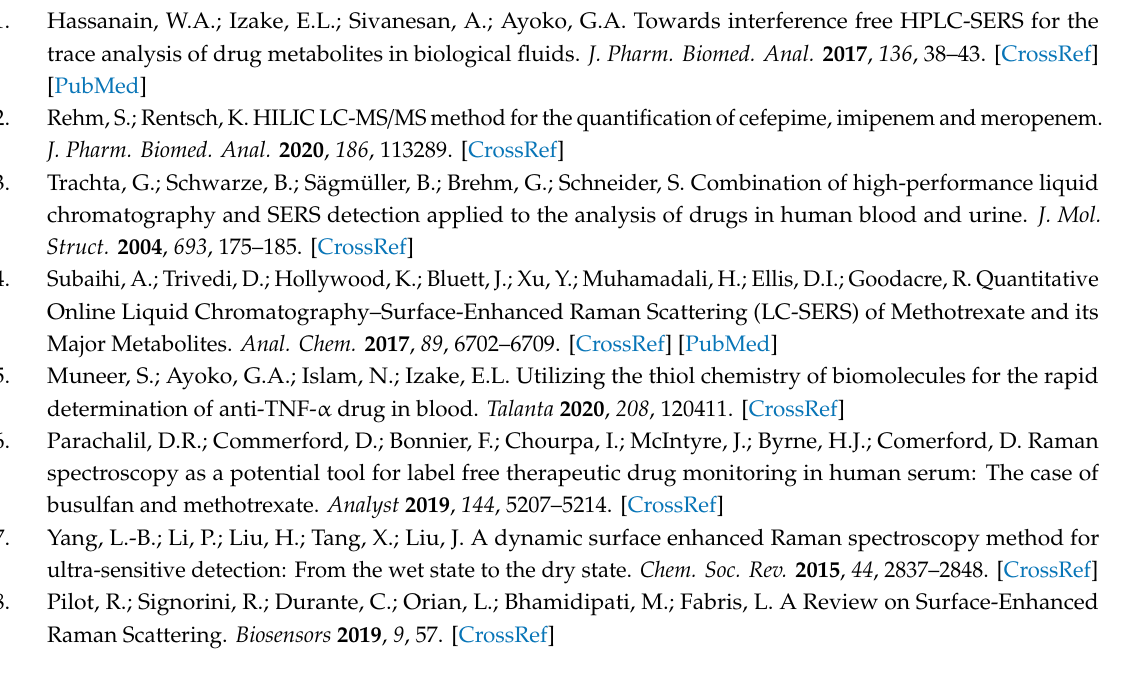
Figure S1. (a) SEM images of gold deposition on nickel foam at di ff erent acquisition times 600, 900, and 1200 s (resolution 1 µ m); (b) SERS spectrum of 2-QT (10 − 6 M) at di ff erent acquisition times 600, 900, and 1200 s; (c) 2-QT on bare nickel foam substrate (10 − 2 M); (d) 2-QT on plasmonic nickel foam substrate (10 − 12 M). Figure S2. Chemical structure of: (a) meropenem; (b) paracetamol. Figure S3. (a) Reproducibility of SERS measurements in human blood plasma (RSD = 2.86%); (b) reproducibility of signals on SERS measurements in aqueous solution (RSD = 5.52%) (MPN conc. 200 µ g / mL, 5 × 10 − 4 M). Figure S4. Degradation of drug in aqueous medium over time measured by plasmonic nickel SERS sensor. Figure S5. SERS spectra of (a) meropenem (MPN) spiked in human blood plasma; (b) MPN in aqueous solution; (c) blank plasmonic nickel substrate. Figure S6. (a) Trend of SERS signal intensity of MPN in human blood plasma in concentration range of 5 × 10 − 4 M to 1 × 10 − 12 M; (b) SERS calibration plot of MPN in human blood plasma within the same concentration range. Figure S7. (a) MPN high-performance liquid chromatography (HPLC) chromatograms ( n = 3) (RT = 5.22 min): (i) blank solvent, (ii) standard MPN in aqueous solution, (iii) blank human plasma, (iv) MPN spiked in human plasma; (b) calibration curve of MPN by HPLC (working concentration range 0.25 to 18 µ g / mL). Figure S8. SERS spectra of (a) (i) MPN on plasmonic nickel SERS substrate (ii) SERS substrate after desorption of MPN (iii) Fresh aliquot of MPN on recycled SERS substrate (b) Repeated cycles of measurements. Figure S9. SERS spectra of 5 × 10 − 4 M MPN on plasmonic nickel foam. The spectra were acquired by the handheld Raman spectrometer (a) using automatic background correction, (b) without background